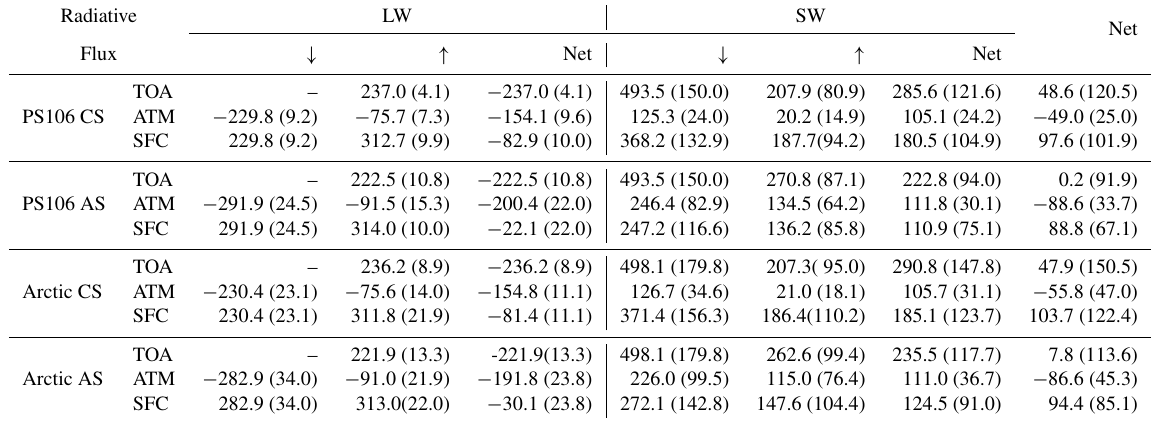
Table B1. Radiation budget for PS106 for all-sky (AS) and clear-sky (CS) conditions based on the CERES SYN1deg data set. Values represent mean and standard deviation (in parentheses) from 28 May to 20 June, 22 June to 16 July